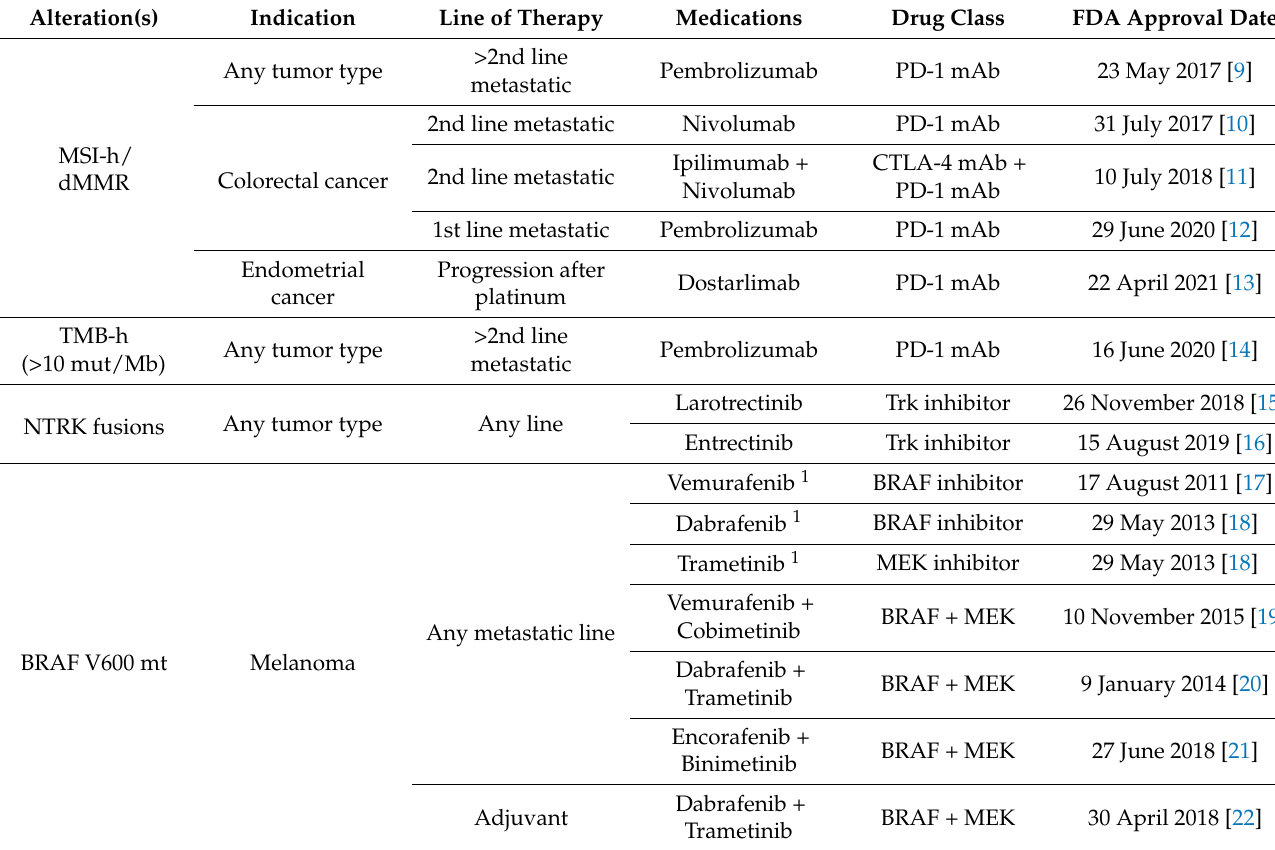
Table 1. Molecular alterations guiding therapy with agents approved in multiple tumor